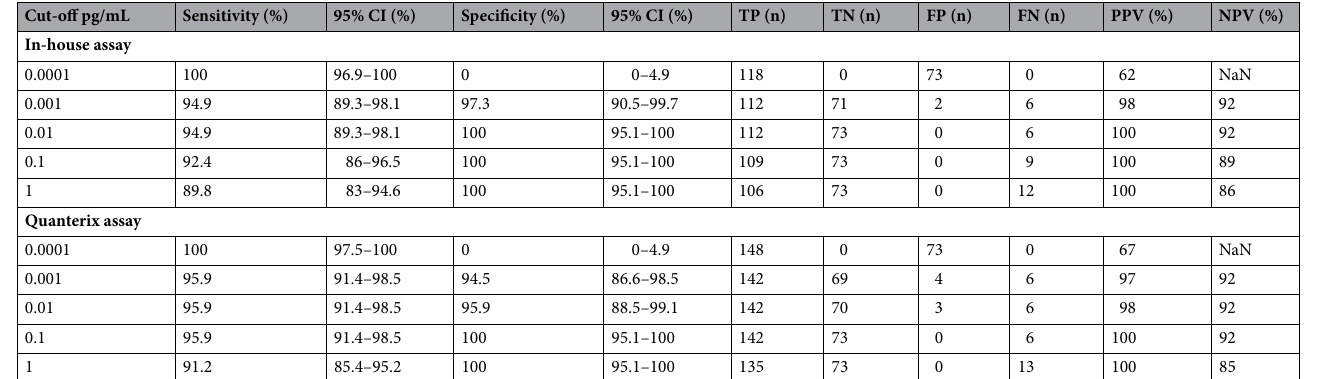
Table 1. Sensitivities and specificities depending on different cut-offs. True positive (TP), false negative (FN), true negative (TN), false positive (FP), positive predictive value (PPV), negative predictive value (NPV), not a number